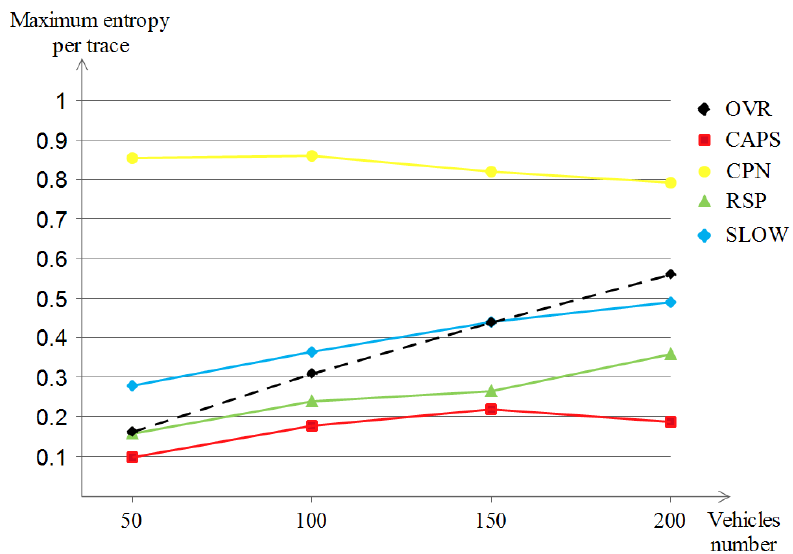
Figure 12. Maximum entropy per trace of privacy schemes in the Manhattan